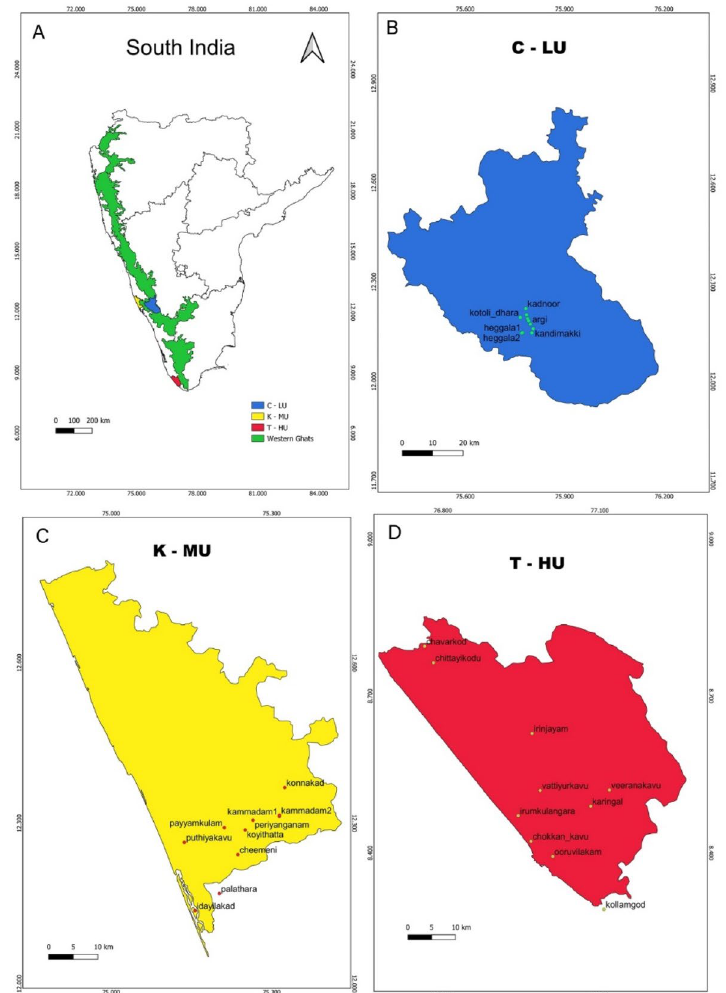
Figure 1. Map of the study locations. ( A ) Peninsular India shows the mountain chains of the Western Ghats biodiversity hotspot and the three locations; ( B ) the map of Kodagu district (less-urbanized location—C-LU) shows the sampling sites; ( C ) the map of Kasaragod district (moderately-urbanized location—K-MU) shows the sampling sites; ( D ) the map of Trivandrum district (highly-urbanized location—T-HU) shows the sampling sites. Map is created in QGIS version